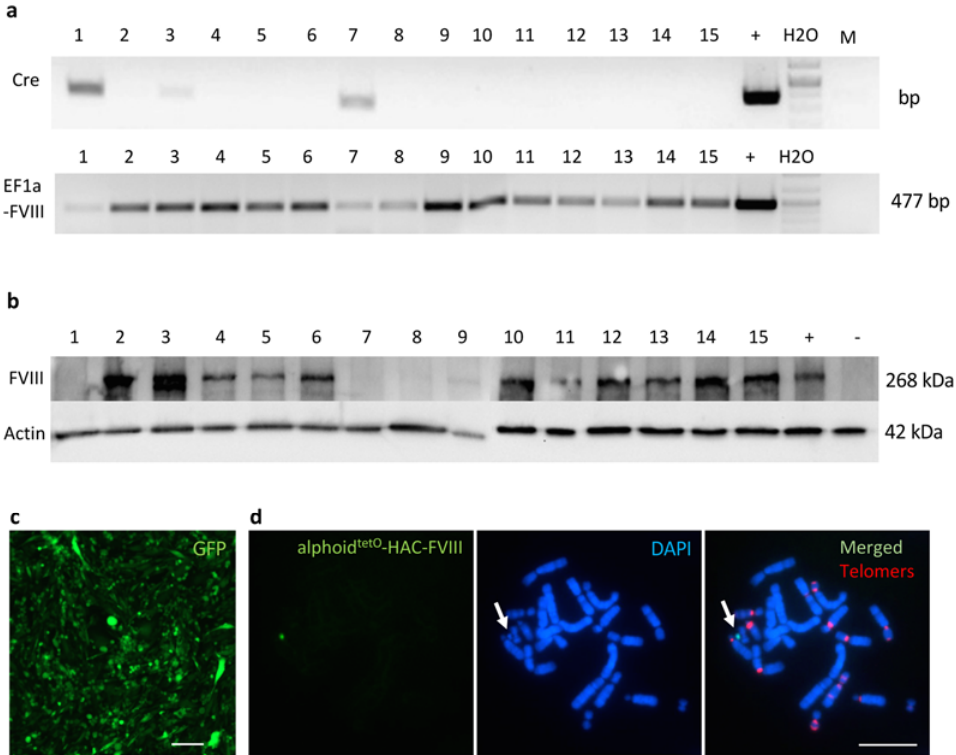
Figure 2. CHO cells with the alphoid tetO -HAC-FVIII. ( a ) DNA amplification of the Cre-recombinase gene fragment from the CHO-alphoid tetO -HAC-FVIII clones by PCR (upper gel). DNA amplification of the EF1-alpha-FVIII gene fragment from the CHO-alphoid tetO -HAC-FVIII cell clones by PCR (lower gel). ( + )—the plasmid control. ( b ) Analysis of FVIII protein expression in the CHO-alphoid tetO -HAC-FVIII by Western blot. Clones are indicated by numbers. ( + )—control CHO cells transfected with the p-FVIII vector. (-)—CHO cells without HAC. ( c ) CHO cells with the alphoid tetO -HAC-FVIII expressing EGFP (clone 2) cultured after HAT-selection and BSD-selection, scale bar—100 µ m. ( d ) Fluorescence in situ hybridization assay of the CHO clone 2 with the alphoid tetO PNA-FITC probe (green) and the telomere PNA-TRITS probe (red). The alphoid tetO -HAC-FVIII is indicated by an arrow. Scale bar—10 µ m, color-coded markers are indicated on the image.